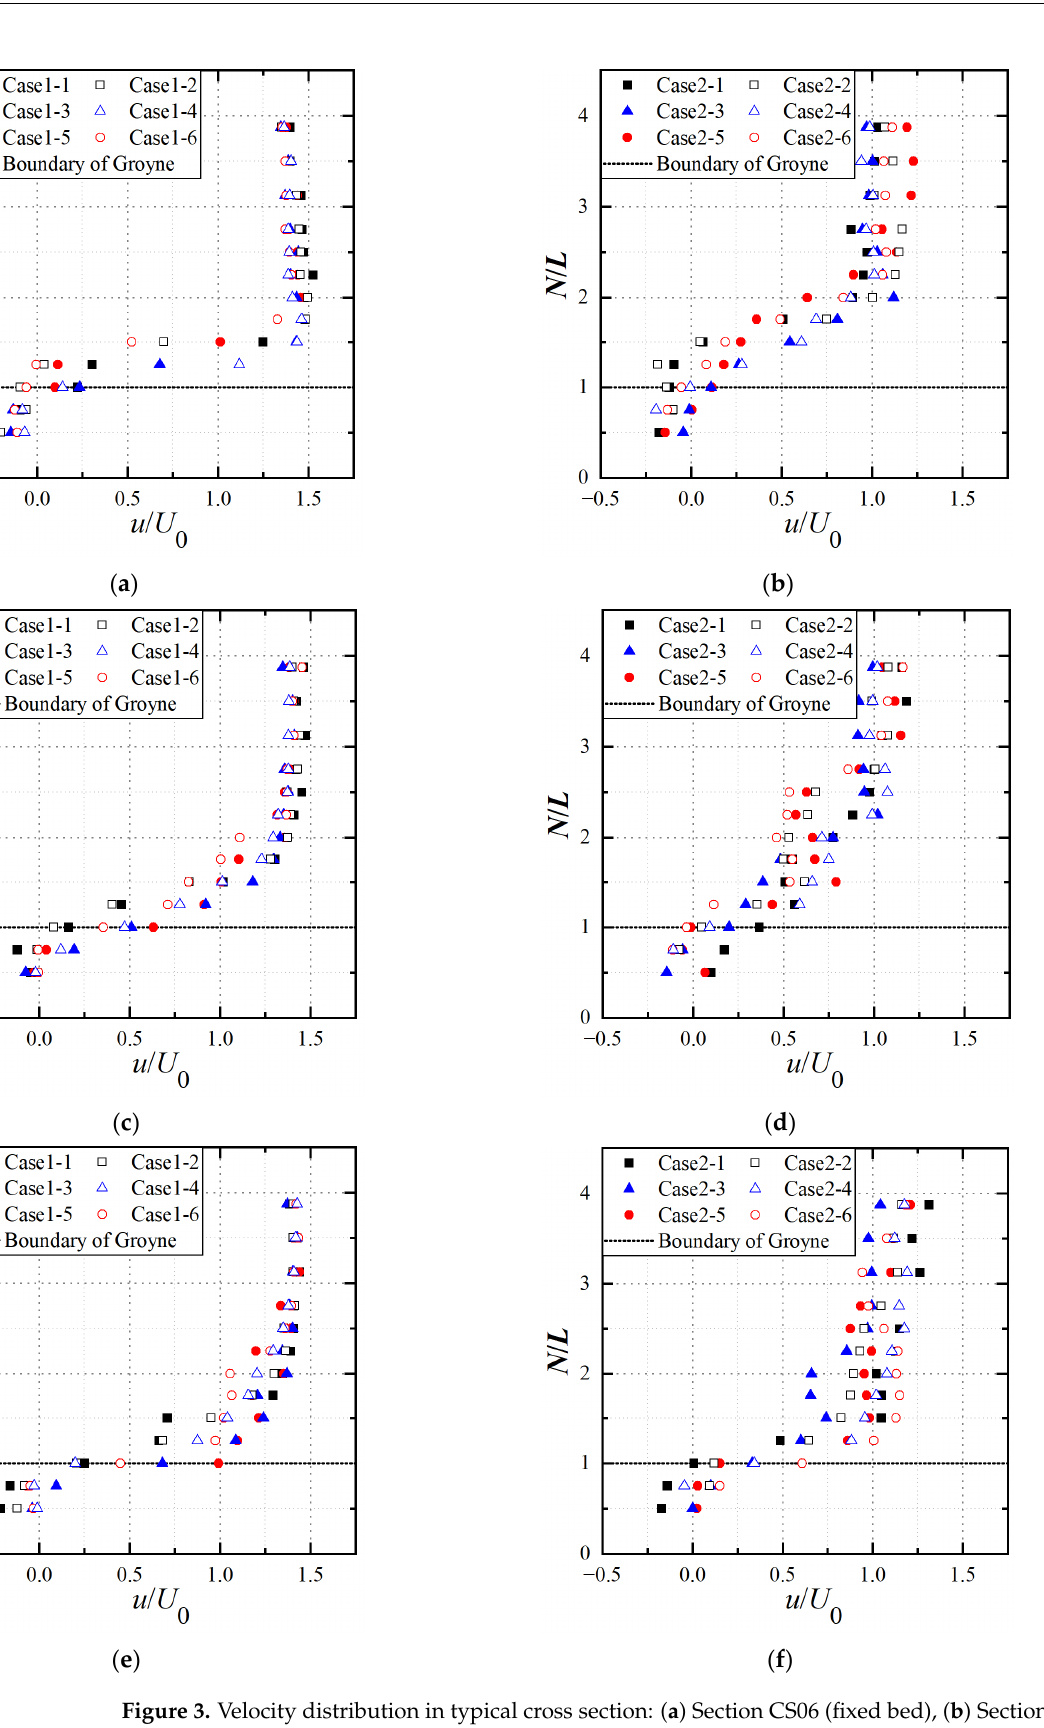
( b ) Figure 4. Streamwise velocity at the head of the four groins: ( a ) Velocity at the head of groin (fixed bed) and ( b ) Velocity at the head of groin (mobile bed).